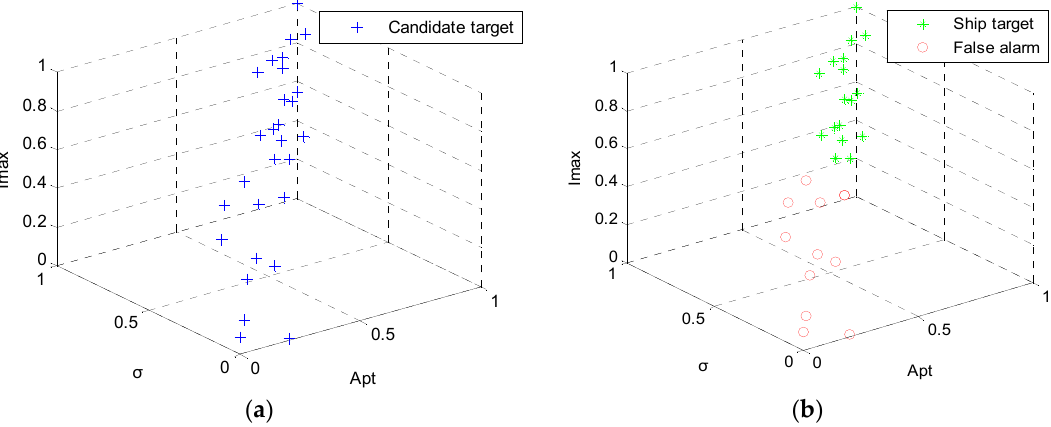
Figure 14. Candidate target feature space ( a ) and preliminary discrimination results ( b ) for test image ID 1.